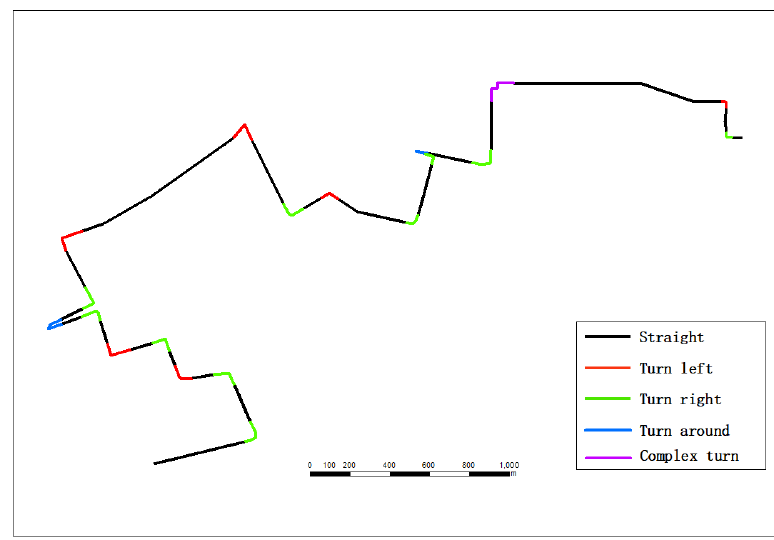
Figure 15. Navigation information generated by this algorithm. Table 7. Deviation between actual cycling trajectory of volunteers and navigation route.